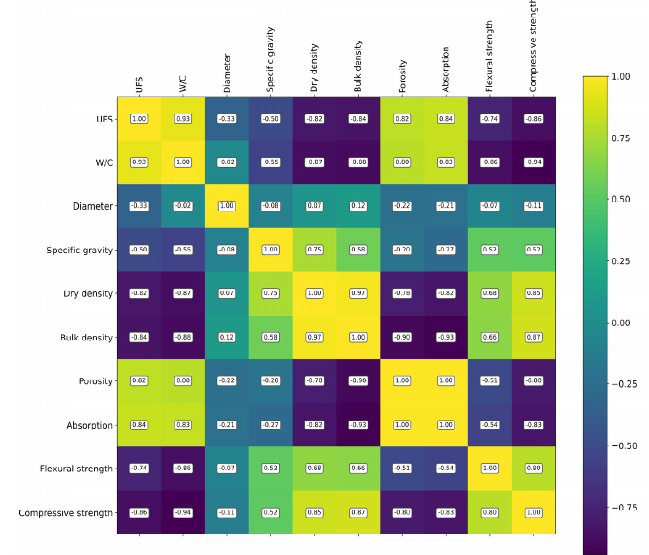
Figure 20. Correlation matrix of analysed parameters.